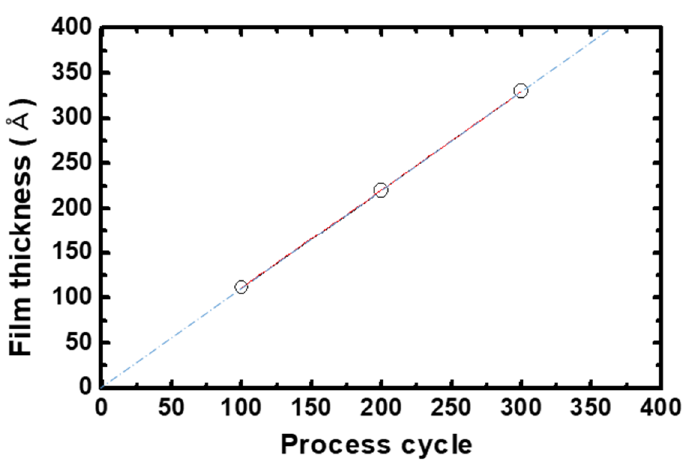
Figure 4. AlN film thickness values as a function of ALD cycles (NH 3 plasma power: 100 W).